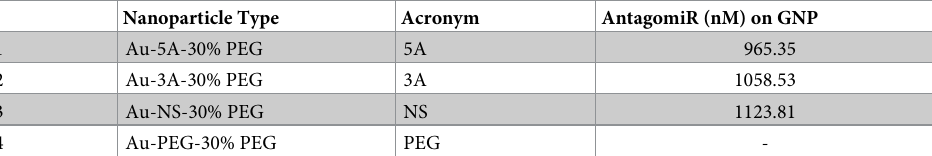
Table 2. GNPs used in this